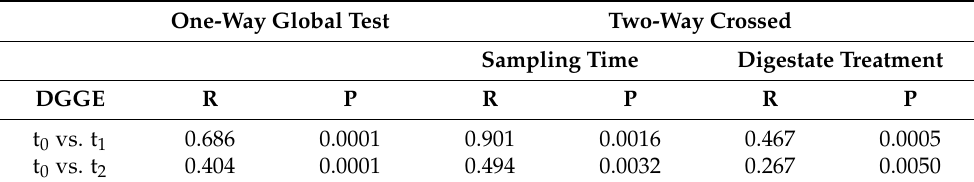
Table 8. Summary of ANOSIM analysis based on the 16S-cDNA Dice similarity matrices. In the one-way ANOSIM groups were analysed independently (three fertilizer treatments vs. four sampling time), whereas the two factors (sampling time and fertilizer treatments) were analysed by a two-way